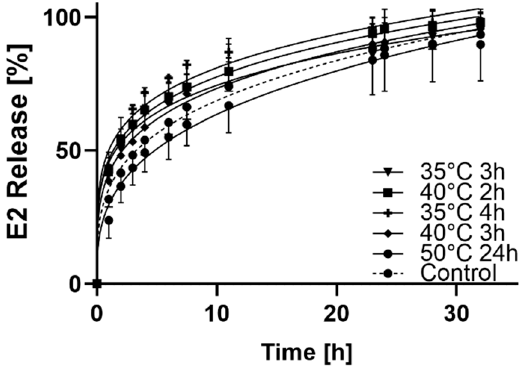
Figure 3. In vitro release profile in phosphate buffered saline (PBS, pH 7.4) at 32 °C.